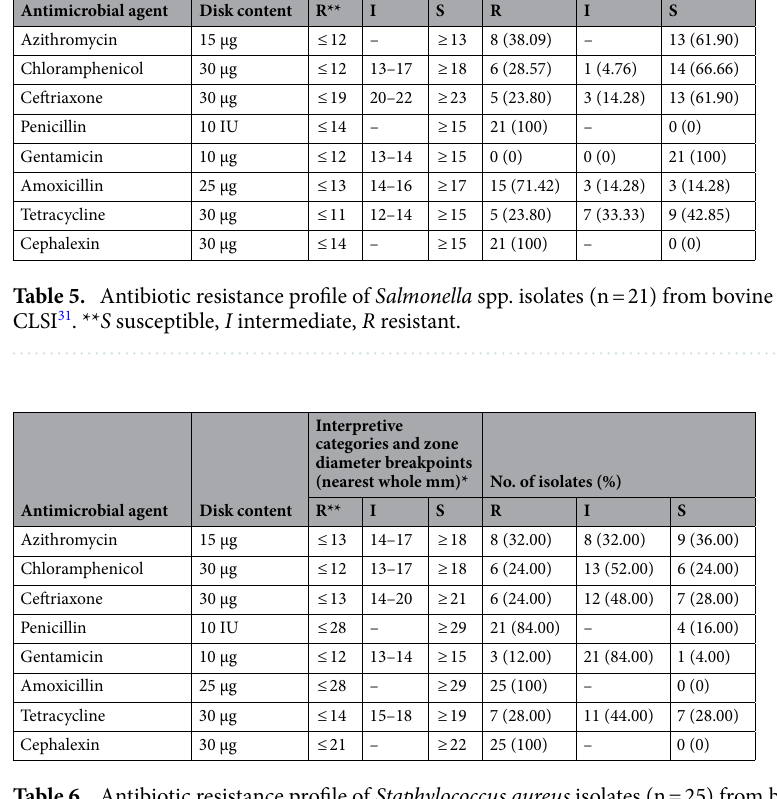
Table 6. Antibiotic resistance profile of Staphylococcus aureus isolates (n = 25) from bovine milk samples. *From CA-SFM 59 , CLSI 31 . ** S susceptible, I intermediate, R resistant.